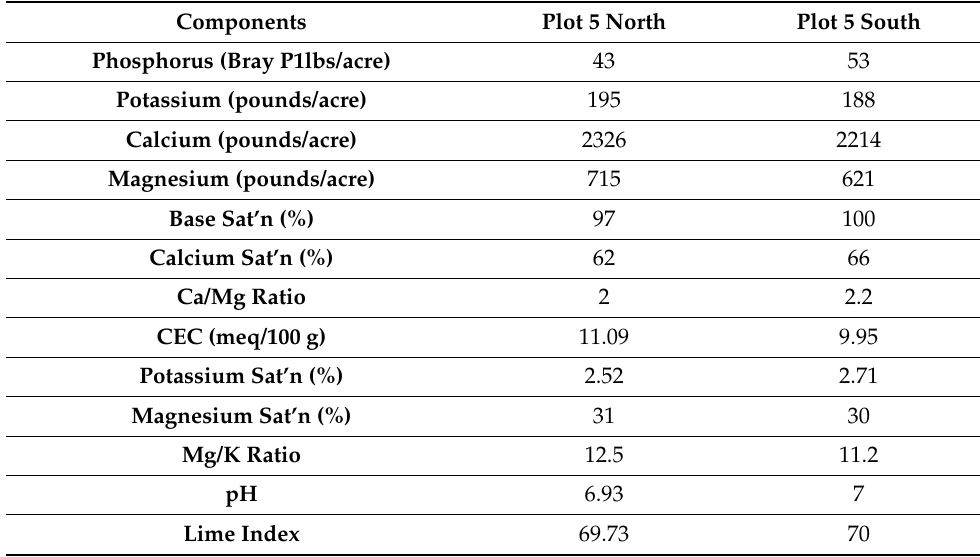
Table A1. Detailed soil characteristics of the experimental plots.